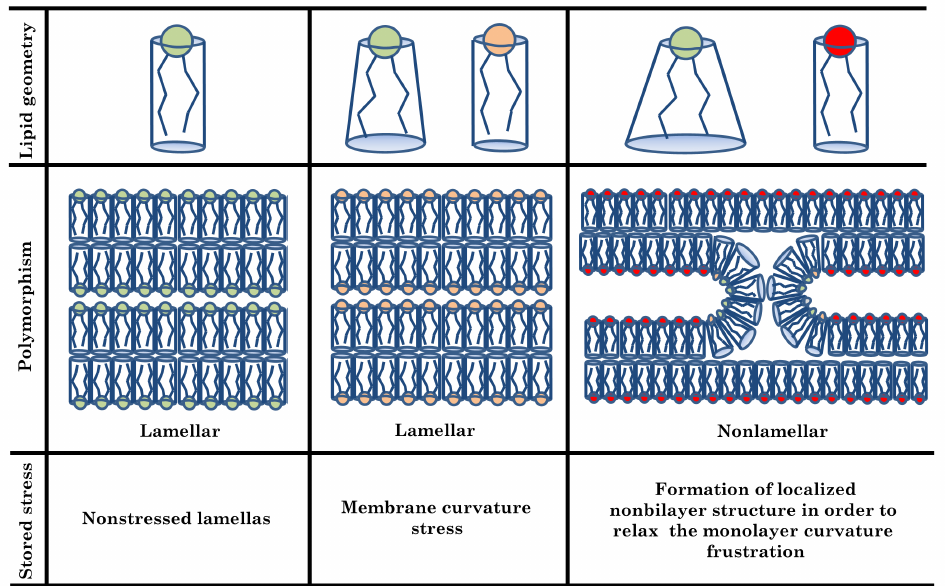
Figure 4. Molecular geometry of lipids and membrane stored stress. Monolayers made of cylindrical molecules of zero spontaneous curvature (SC) can form nonstressed lamellas (first column, green lipid). However, for nonzero SC, lipid molecules have to be reshaped to fit into a flat state, leading to membrane stress (second column, orange lipid). When the stress accumulated in the resulting bilayer is too big, the transition of the lamella into a nonlamellar phase is favorable. The transition begins when small interlamellar contacts having characteristic hourglass shape form (third column, red lipid), lipids with negative SC promotes formation of these localized nonbilayer structures